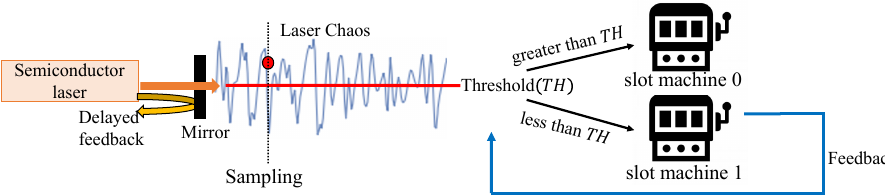
Figure 2. Architecture of laser chaos decision-maker for two-armed bandit problems